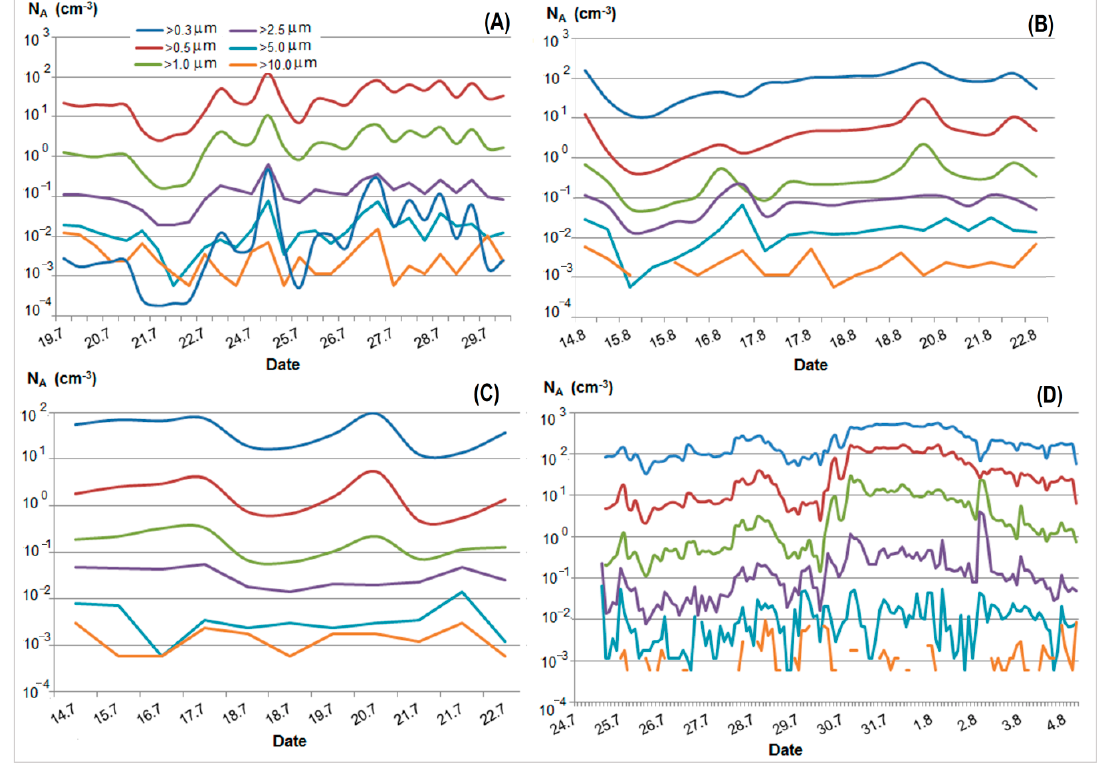
Figure 5. Number concentrations ( N A ) of the atmospheric aerosol in July 2016 ( A ), August 2016 ( B ), June 2017 ( C ), and July–August 2019 ( D ).